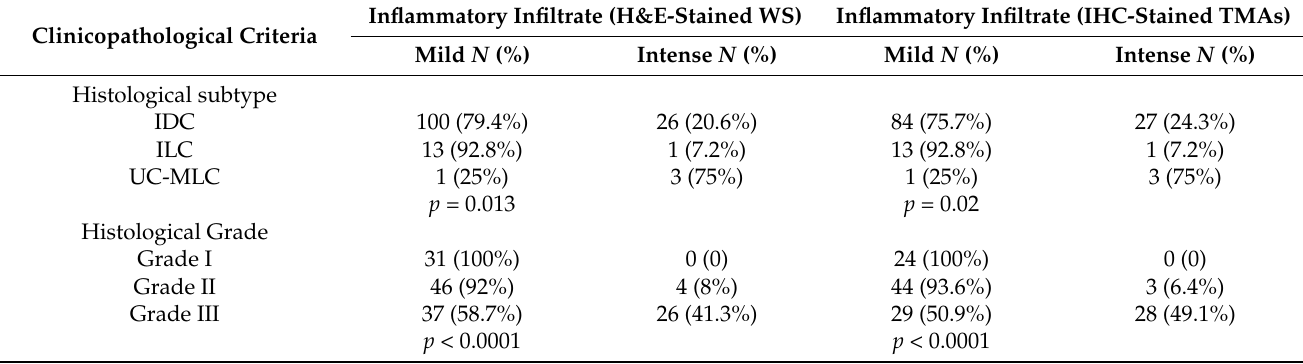
Figure 3. Inflammatory infiltrate in breast cancer. Representative images of fourcases showing whole H&E-stained sections and IHC (single or double) assessment of immune cells on TMAs for the most abundant immune populations CD3 (red)/CD20(brown) and MUM1. ( A ) Mild infiltrate; ( B ) intense infiltrate with CD3 high , CD20 low , and MUM1 low expression; ( C ) intense infiltrate with CD3 high , CD20 high , and MUM1 low expression; ( D ) intense infiltrate with CD3 low , CD20 low , and MUM1 high expression. Scale bars: 100 µ m. Table 5. Correlation between the clinicopathological criteria and the degree of the inflammatory